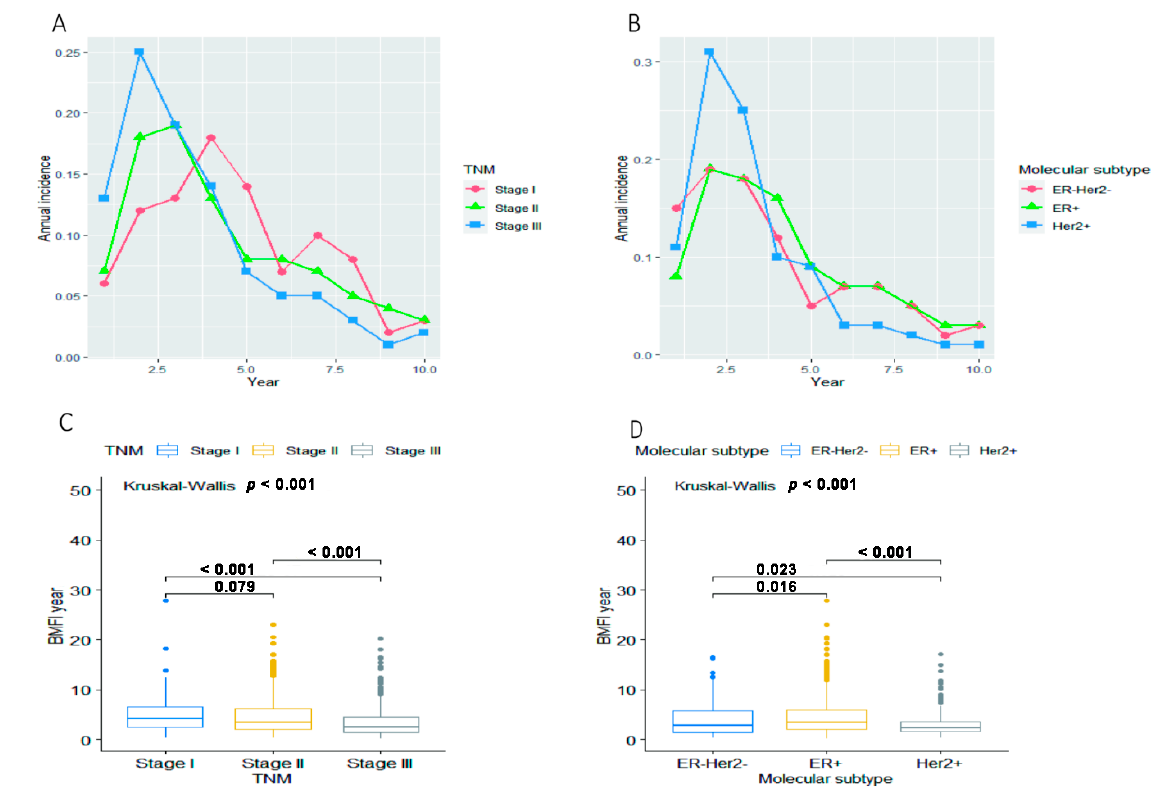
Figure 5. Annual incidence of BM for overall eligible patients (N = 1059) in groups stratified by ( A ) TNM stage and ( B ) molecular subtype. The distribution of BMFI for overall eligible patients (N = 1059) in groups stratified by ( C ) TNM stage and ( D ) molecular subtype. Abbreviations: BM = bone metastasis; BMFI = bone metastasis-free survival; ER = estrogen receptor; Her2 = Human epidermal growth factor receptor 2.